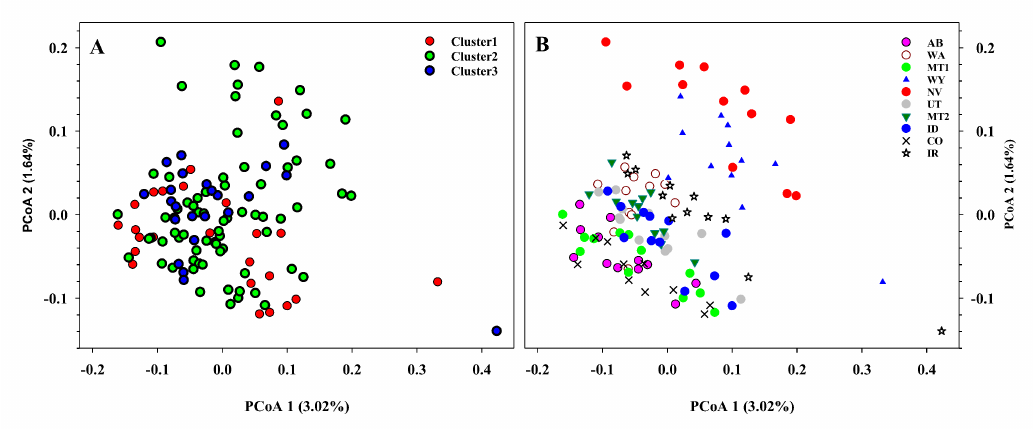
Figure 4. Genetic relationships of the 119 samples of the 10 northern wheatgrass accessions revealed by principal coordinates analysis (PCoA) with the 5659 SNP markers. Two panels are the same, but the left panel ( A ) labels samples for clusters obtained from the STRUCTURE analysis, while the right panel ( B ) labels samples for the 10 accessions (see Table 1 for accession label). Note accessions AB, WA, MT1, and MT2 are cultivated accessions, while the rest are wild